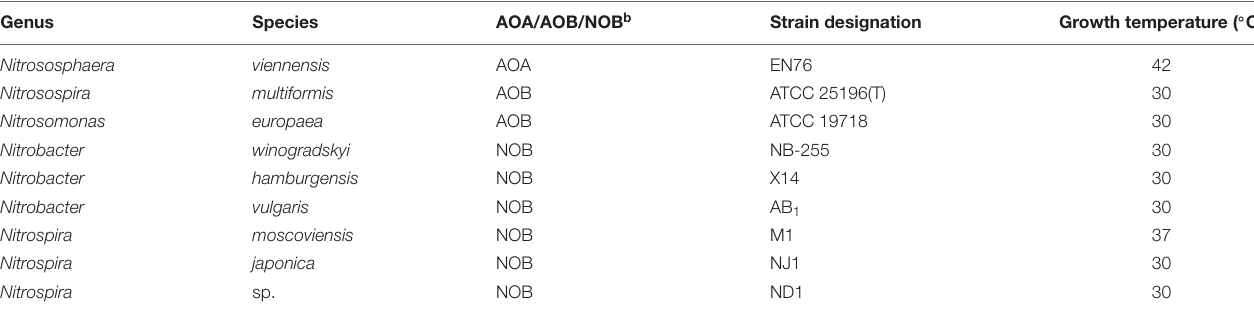
TABLE 1 | Ammonia (NH 3 ) and nitrite (NO 2 − ) oxidizer strains for this study were grown under optimal growth conditions and temperatures a . Genus Species